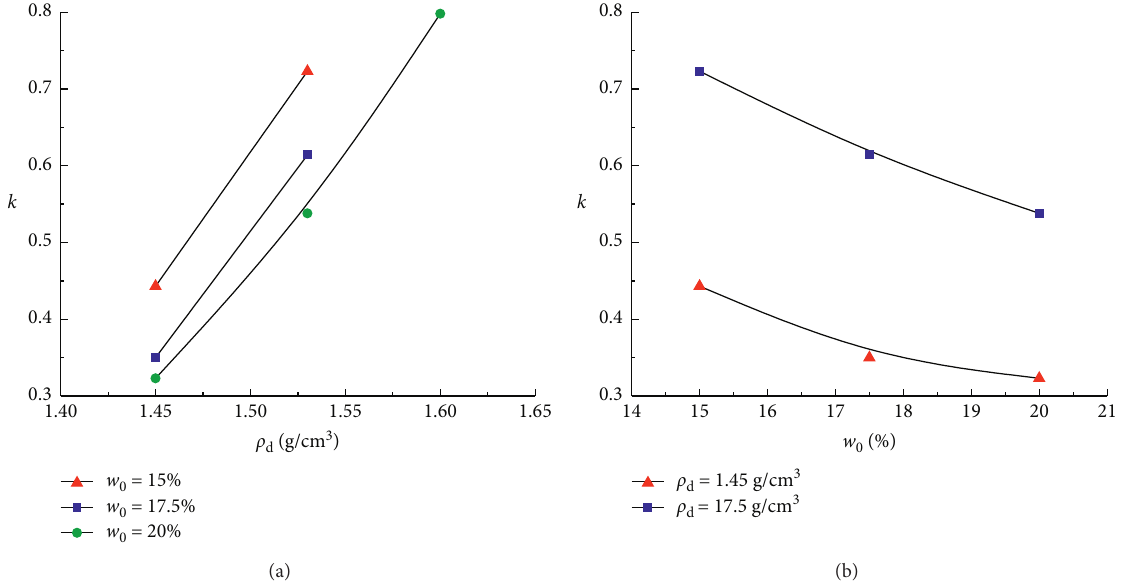
Figure 4: The relationship between the slope of the linear segment and the initial conditions. (a) Relationship to dry density and (b) relationship to initial the moisture